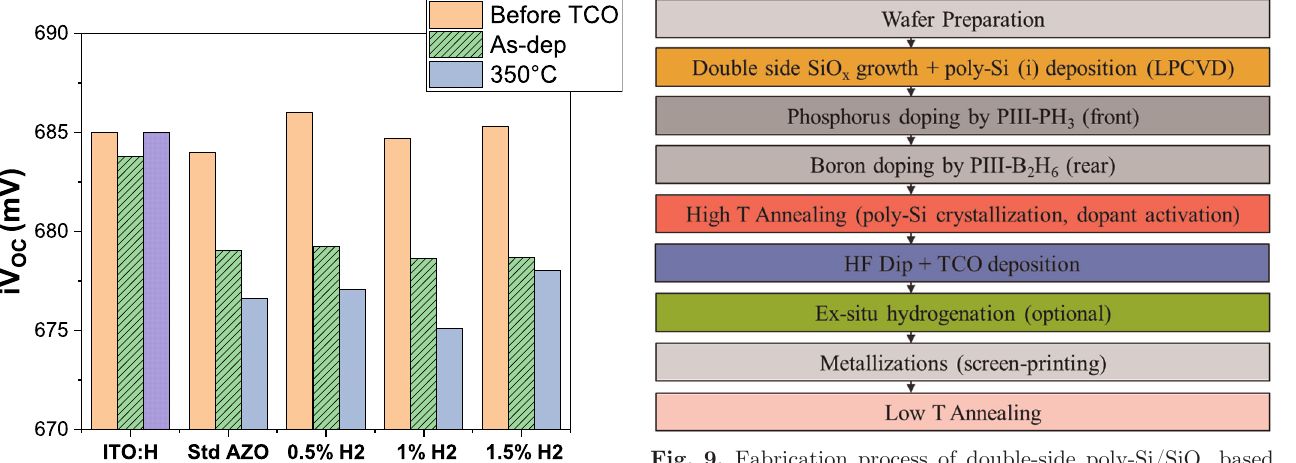
Fig. 8. Variation of iV OC values for symmetrical samples featuring poly-Si p + /SiO x with TCO layers composition and at different process steps.